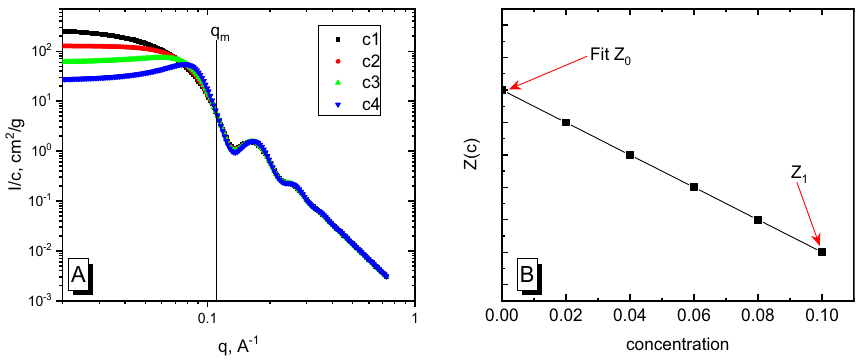
Figure 1. (A) Plot of the scattering intensity divided by the concentration versus the scattering vector. The behavior of scattering curves is independent of the concentration for q > q m . (B) Plot of the integrated ( I·q 2 ) versus concentration. Arrows are pointing to the data points that will be available when proposed method is